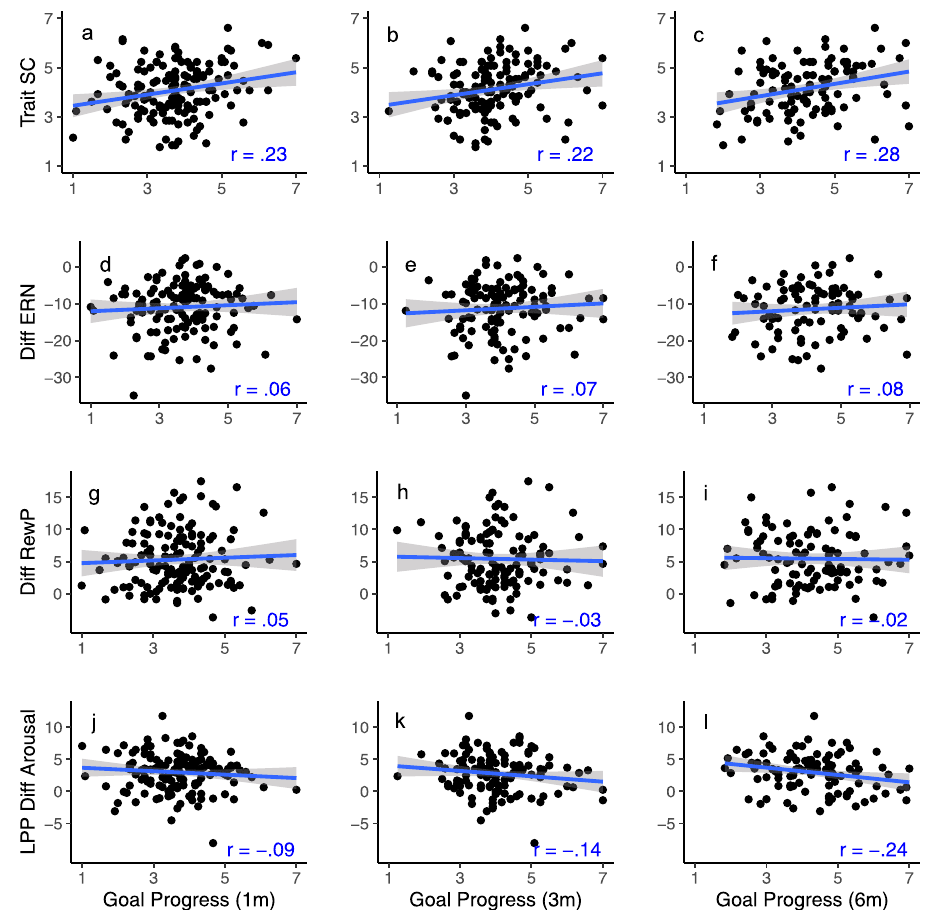
Fig. 6 Scatterplots showing Pearson's correlation coef fi cients between the key individual difference predictors and longitudinal goal progress at 1-, 3-, and 6-month follow-ups. The relationship between goal progress at 1, 3, and 6 months are depicted in separate plots for trait self-control ( a – c ), the difference ERN amplitude ( d – f ), the difference RewP ( g – i ), and the LPP difference between arousal levels ( j – l ). Lines depict simple linear regression to aid visual interpretation, error bands depict the standard error. Trait SC: trait self-control; ERN: error-related negativity; RewP: reward positivity; LPP: late positive